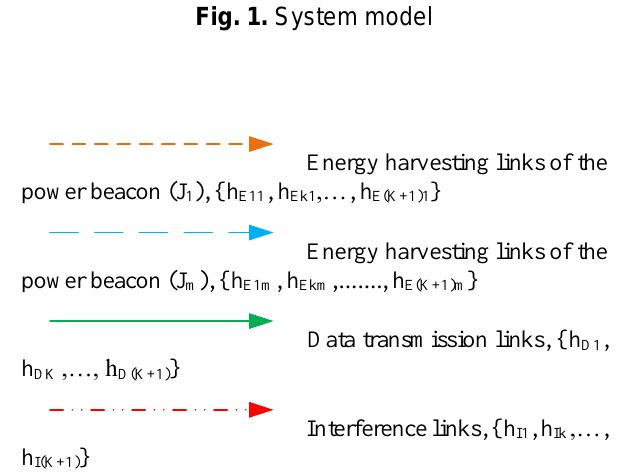
Energy harvesting links of the